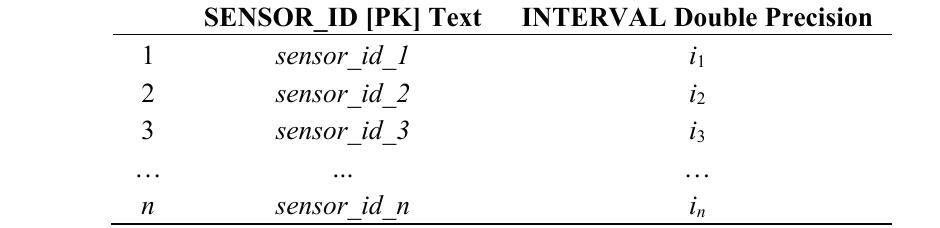
Table 2. Database table that stores sensor and sensor platform data transmission frequencies. SENSOR_ID [PK] Text